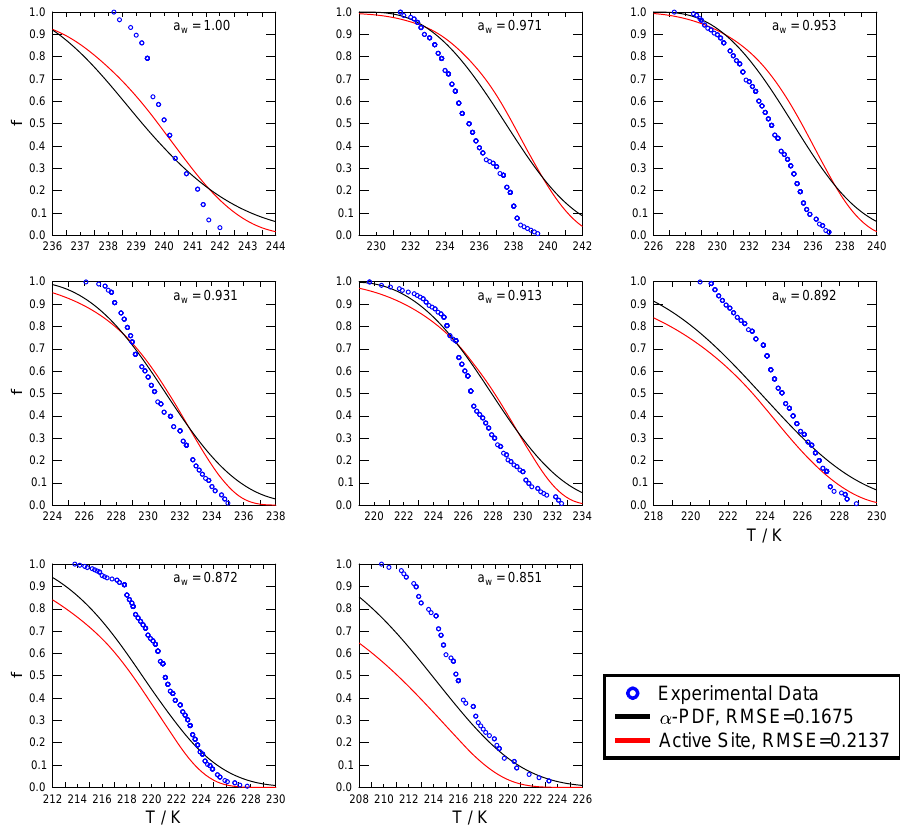
Fig. 6. Resulting immersion freezing descriptions for water and aqueous ( NH 4 ) 2 SO 4 droplets containing leonardite when fitting the entire immersion freezing data set including all investigated a w using α -PDF (black lines) and active sites parameterizations (red lines). The experimentally derived cumulative frozen fraction, f , of droplets in 0.2K temperature increments is represented by blue circles. The fit quality is given by the